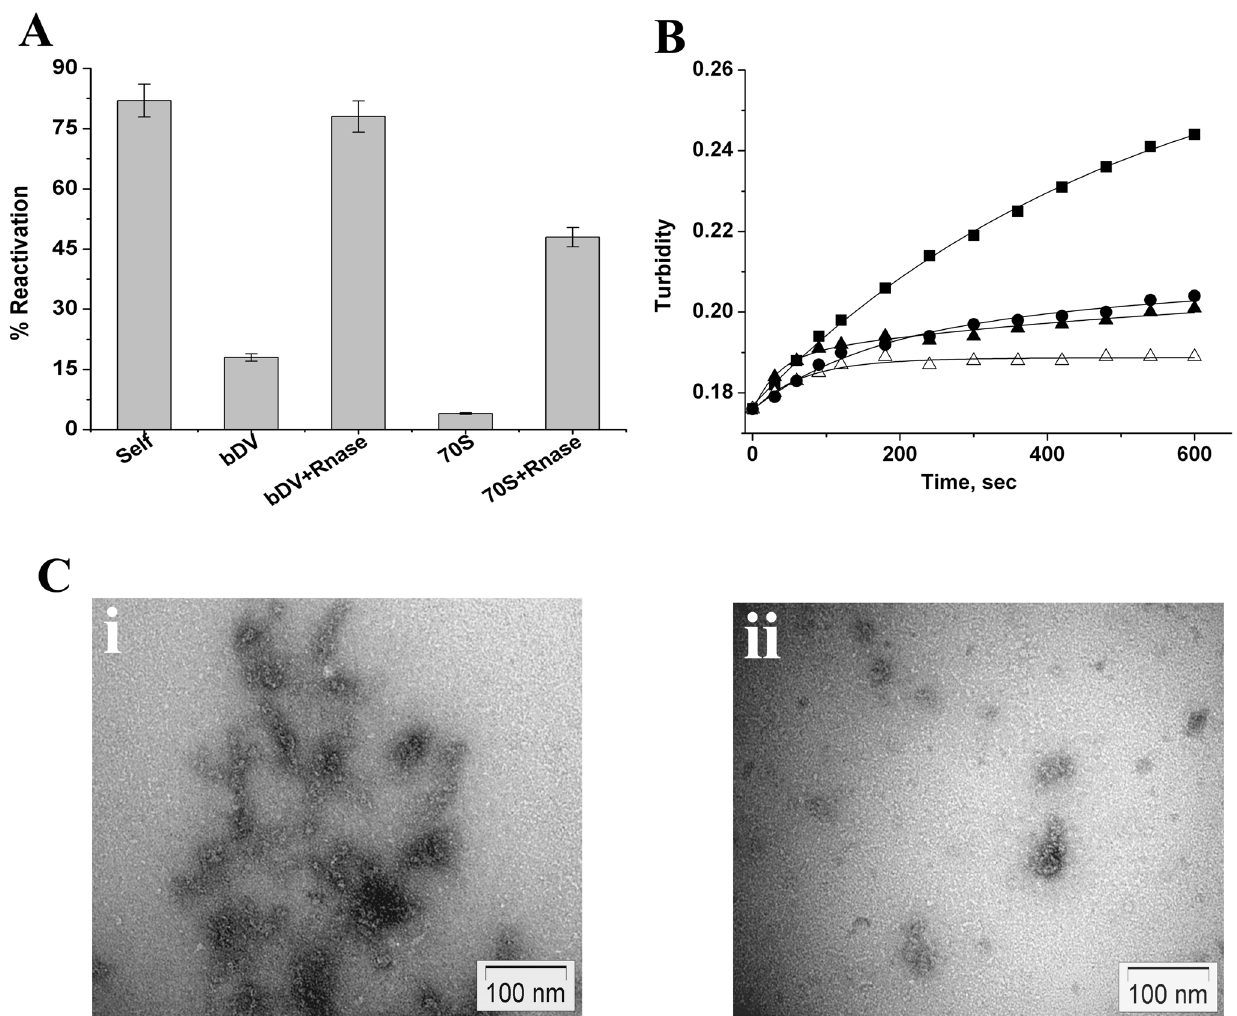
Figure 2. Effect of ribosome and domain V RNA on refolding of lysozyme. A) Reduced-denatured lysozyme (2 m M) was refolded for 16 h in redox buffer (Material and methods). Bar diagram shows the reactivation yields in absence of the chaperone (Self) and in presence of bDV RNA, bDV RNA + Rnase. Reactivation yields in presence of 70S ribosome (70S) and Proteinase K treated and phenol extracted ribosome that was digested with RNase (70S ribosome + Rnase) are also shown. B) Time course of change in turbidity at 450 nm of reduced-denatured lysozyme (2 m M ) upon dilution of denaturant into the non-redox buffer (Material and methods), in absence of chaperone (- & -), in presence of bDV RNA (- RNA (- m -) and 70S ribosome (- D -). C) Negative staining transmission electron micrographs of reduced-denatured lysozyme under refolding condition in absence (i) and in presence of bDV RNA (ii). Molar ratio of BCAII to bDV RNA is 1:1.